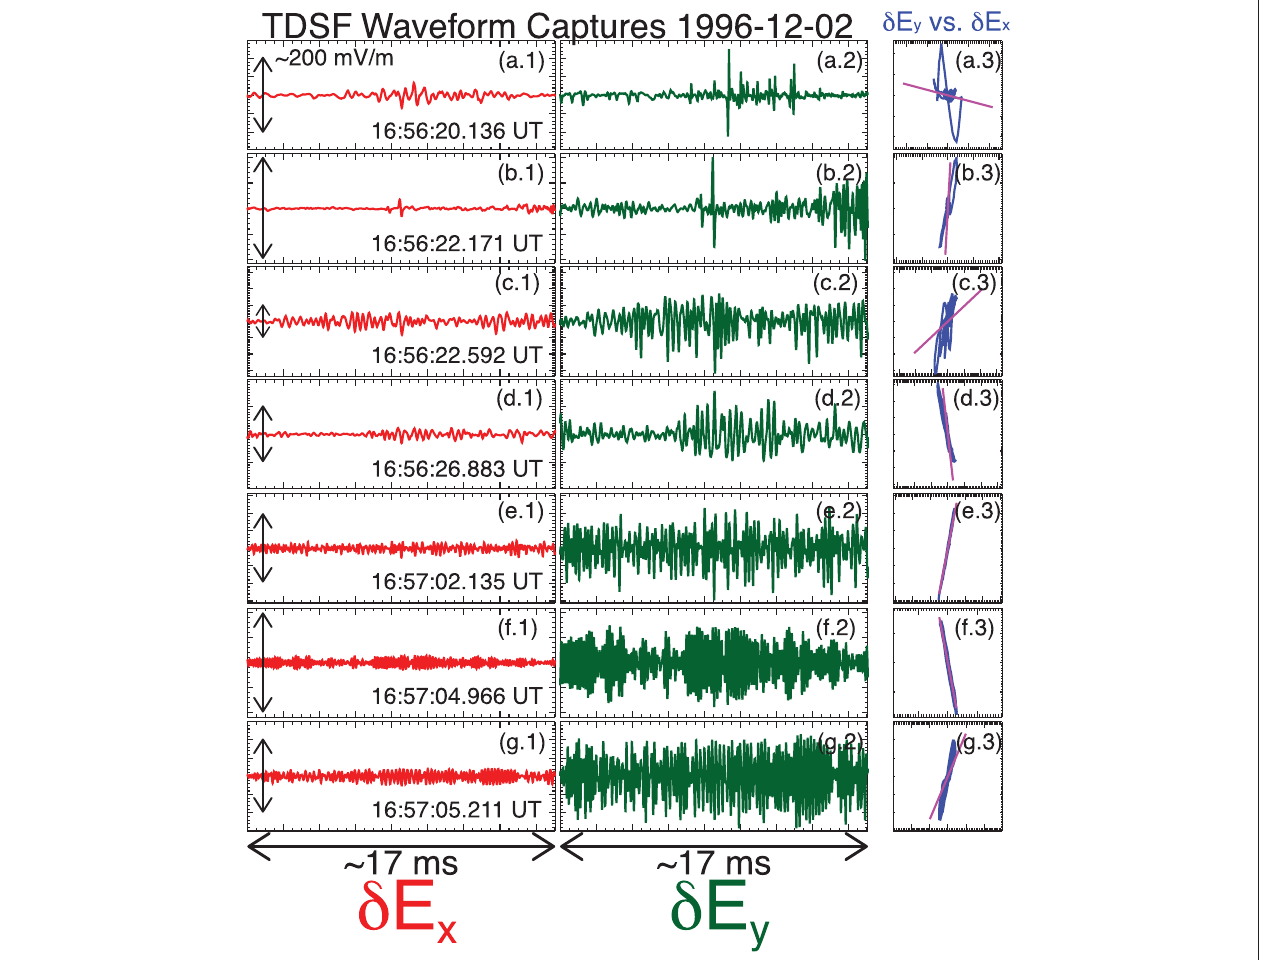
FIGURE 1 | Example of six waveform captures observed by Wind while crossing the Earth ’ s quasi-perpendicular bow shock on 1996-12-02. Each row corresponds to, by column, the X vs time, Y vs time, and Y vs X hodogram (in instrument coordinates) from the Wind /WAVES time domain sampler (TDS) instrument (Bougeret et al., 1995). Each waveform capture/snapshot is ∼ 17 ms in duration. The quasi-static magnetic fi eld projection is shown as the magenta line in hodograms (Adapted from Figure 3.6 in Wilson (2010).